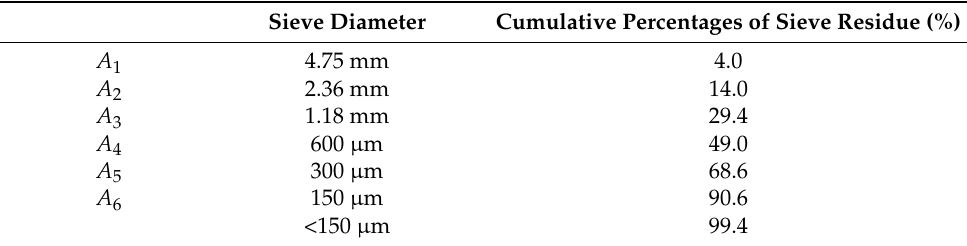
Table 2. Screening test results of sea